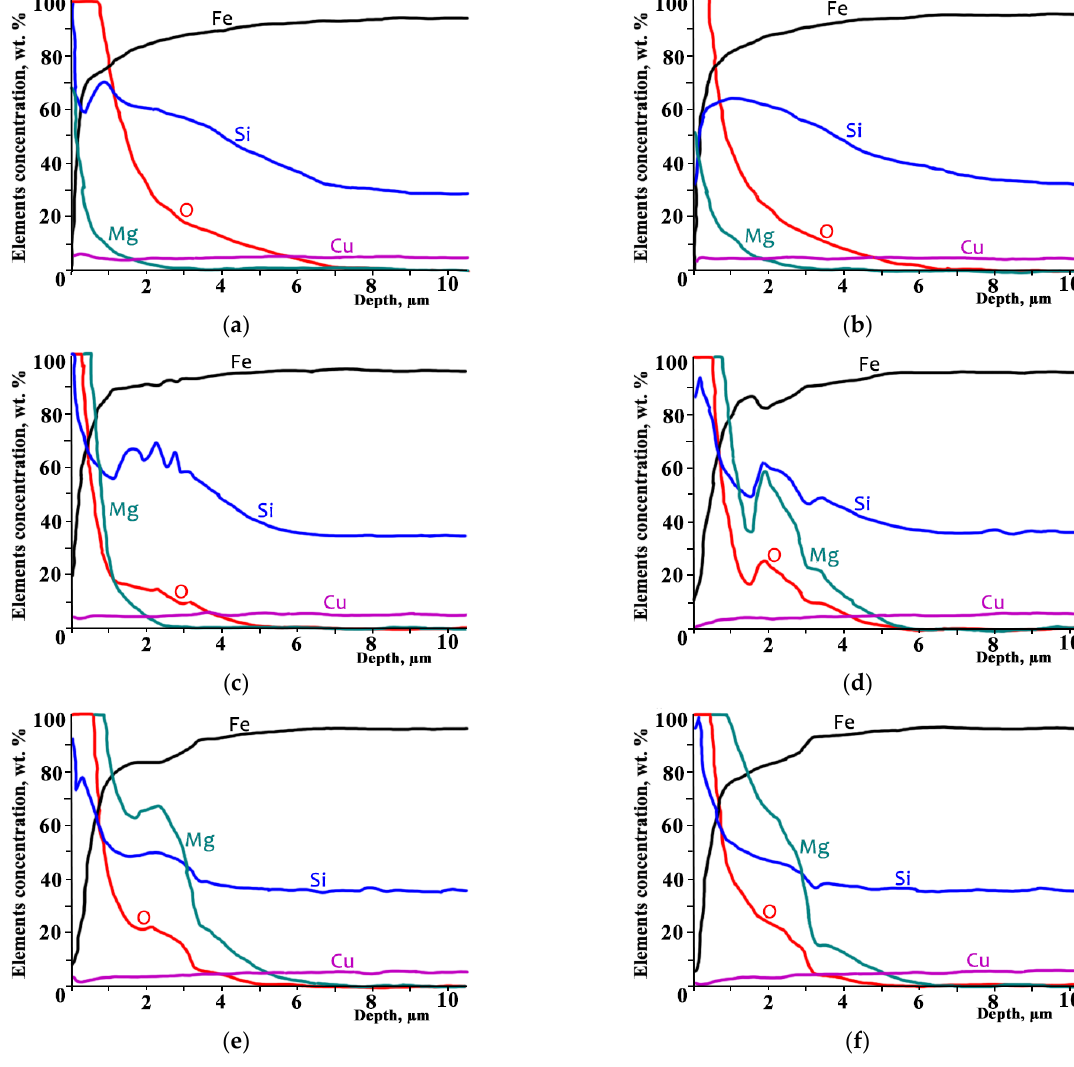
Figure 3. Distribution of elements in the surface layer of Fe-3%Si-0.5%Cu alloy with MgO coating after annealing at T ≤ N °C, where N = ( a ) 600 °C; ( b ) 700 °C; ( c ) 800 °C; ( d ) 900 °C ( e ) 1000 °C; ( f ) 1100 °C; the scale: Fe is × 1, Si, Mg, O, Cu is × 0.1.